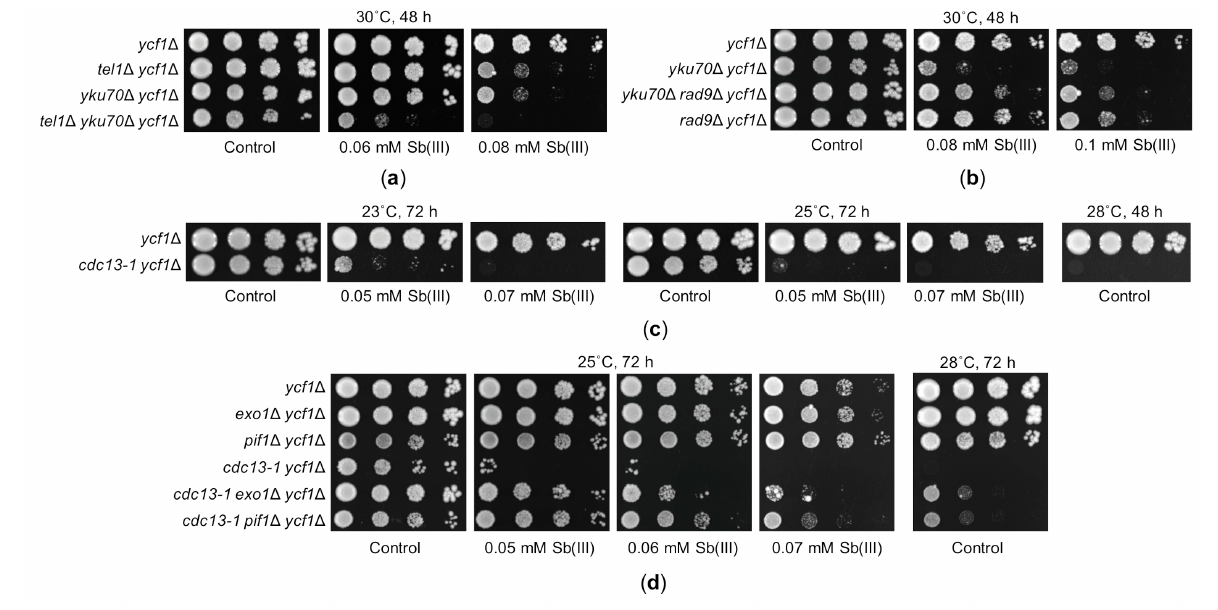
Figure 7. Sb(III) sensitivity of telomere maintenance mutants is suppressed by either checkpoint inactivation or preventing resection of chromosome ends. ( a ) Genetic interaction between tel1 ∆ and yku70 ∆ in the presence of Sb(III). ( b ) Deletion of RAD9 checkpoint gene suppresses sensitivity of yku70 ∆ to Sb(III). ( c ) The cdc13-1 mutation renders yeast cells hypersensitive to Sb(III) at both permissive (23 ◦ C) and semi-permissive (25 ◦ C) temperature. ( d ) Sb(III) sensitivity of cdc13-1 ycf1 ∆ cells is reversed by concomitant deletion of EXO1 or PIF1 . ( a – d ) Exponentially growing cultures were serially diluted and spotted onto YPD plates with or without